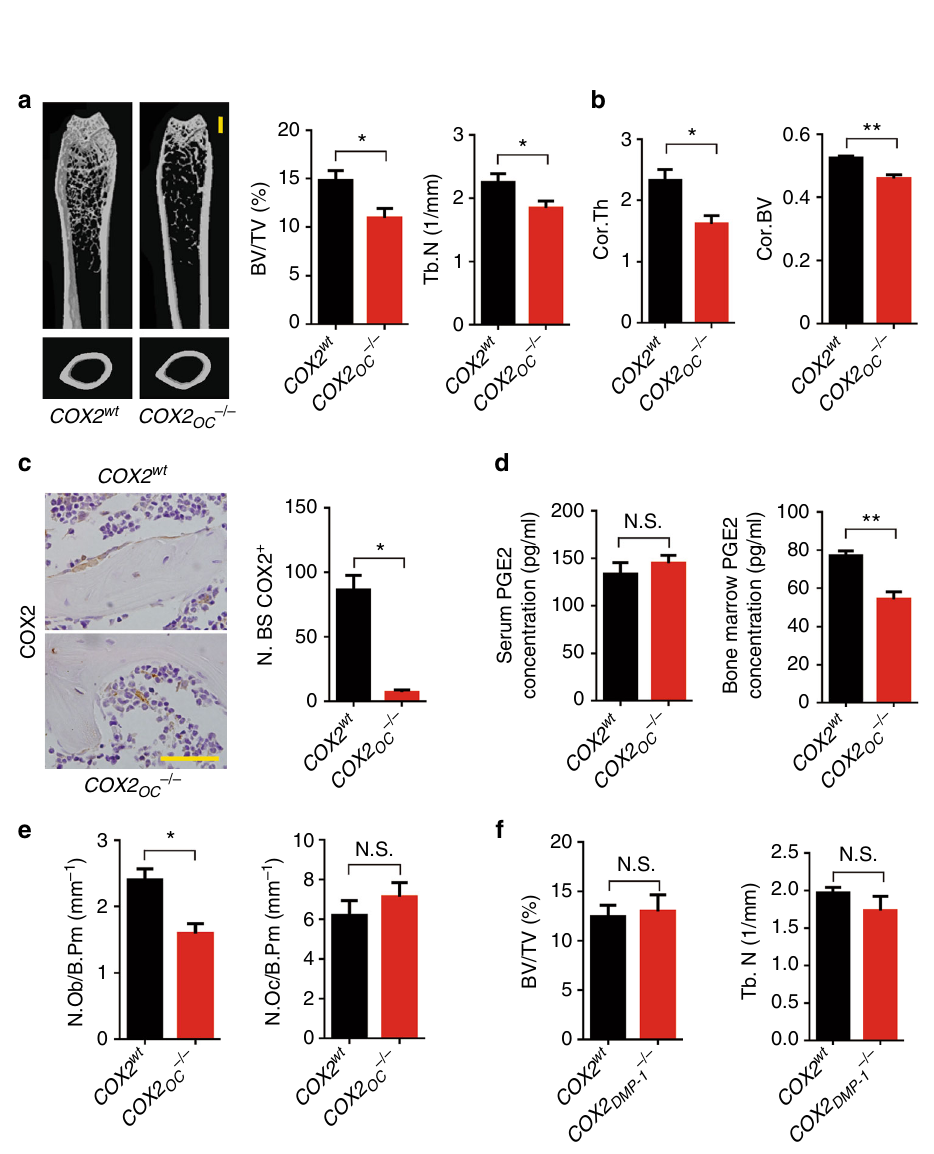
Fig. 5 Ablation of COX2 in osteoblasts leads to reduced bone formation. a Representative μ CT images of the femurs of 12-week-old COX2 wt and COX2 OC − / − mice. Quantitative analysis of the trabecular bone fraction (Tb. BV/TV) and trabecular number (Tb. N). Scale bar: 1 mm. b Quantitative analysis of cortical thickness (Ct. Th) and cortical bone volume (Cor. BV). c Representative images of immunostaining and quantitative analysis of the COX2 + cells (brown) on trabecular bone surface of femoral bone from 12-week-old COX2 wt and COX2 OC − / − mice. Scale bar, 20 μ m. d ELISA analysis of the serum and bone marrow PGE2 in 12-week-old COX2 wt and COX2 OC − / − mice. e Histomorphological analysis of osteoblast (N.Ob/B.Pm) and osteoclast (N.Oc/B.Pm) numbers on the trabecular bone surface of 12-week-old COX2 wt and COX2 OC − / − mice. f Quantitative analysis of the trabecular bone fraction (Tb. BV/TV) and trabecular number (Tb. N) of the femurs from COX2 wt and COX DMP-1 − / − mice. N ≥ 5 per group. * P < 0.05, ** P < 0.01 and N.S. means not signi fi cant. (Student t- test) NATURE COMMUNICATIONS| (2019) 10:181